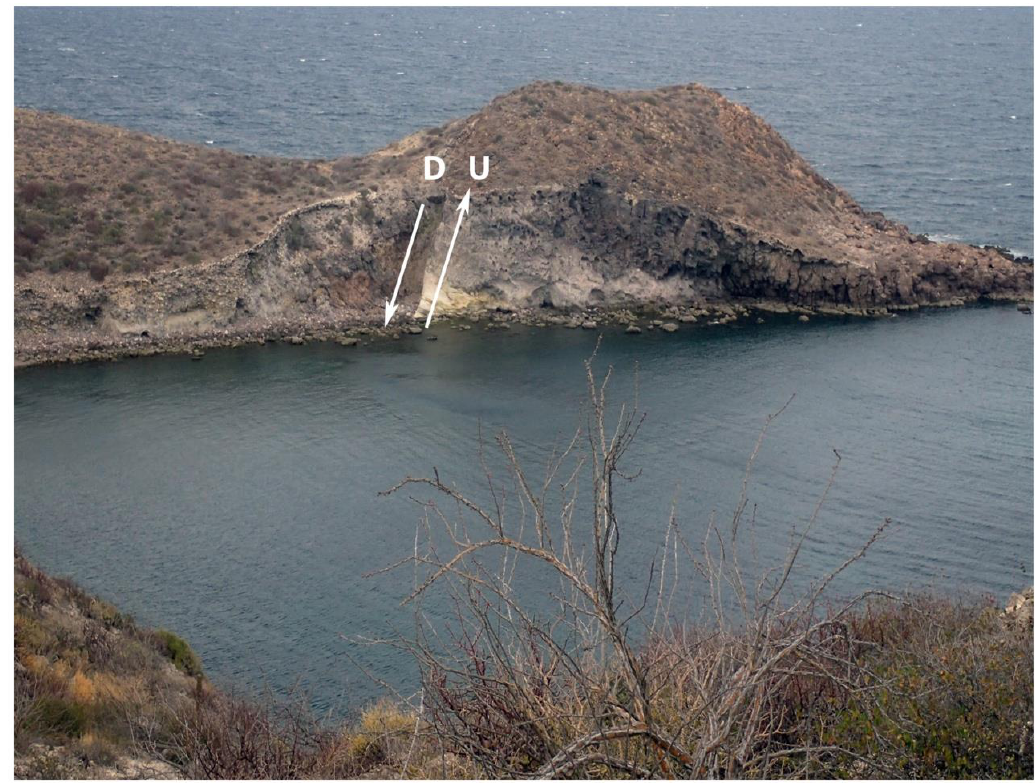
Figure 11. Normal fault through a rhyolite dome exposed in the side wall of a small embayment east of Ensenada Almeja (see NE-SW trending fault in Figure. 2B).